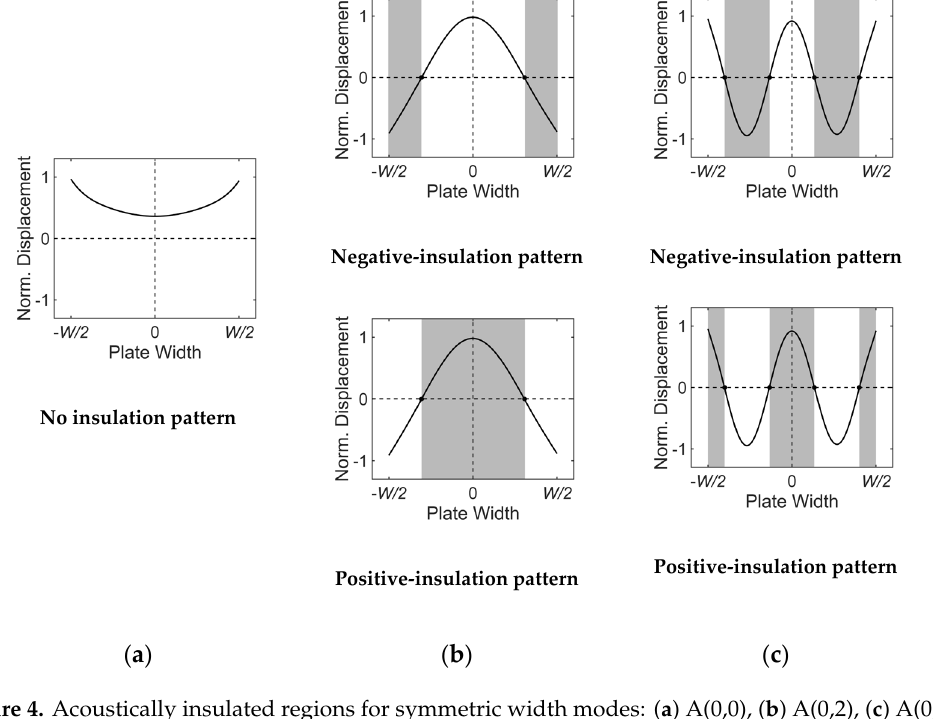
Figure 4. Acoustically insulated regions for symmetric width modes: ( a ) A(0,0), ( b ) A(0,2), ( c ) A(0,4) modes; the shadowed are acoustically insulated regions.